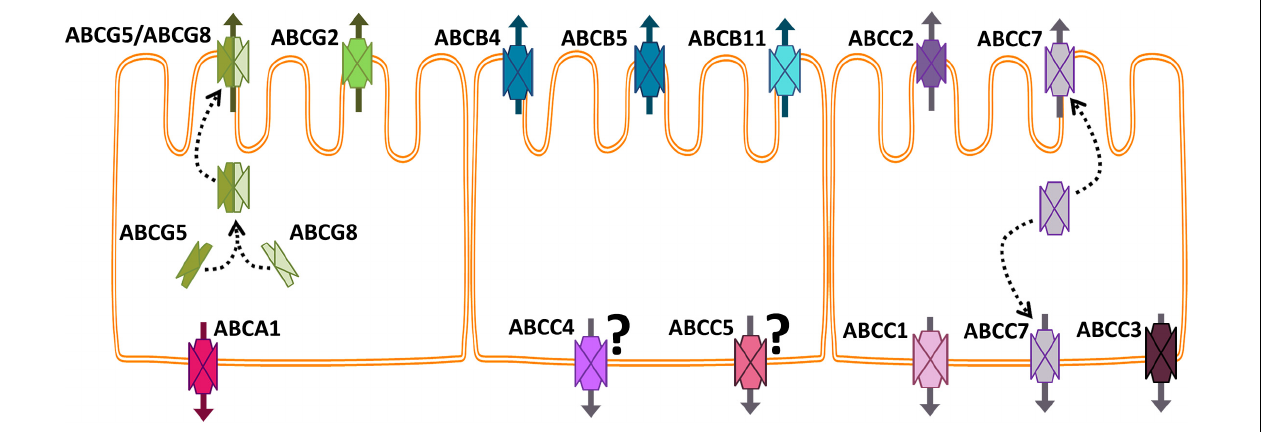
FIGURE 2 | Schematic representation of the intestinal epithelium showing the most studied fish ABC proteins localized. Arrows indicate the direction of the substrates’ transport. The question mark next to ABCC4 and ABCC5 indicates that the basolateral location of these proteins in the intestine has not been confirmed yet for